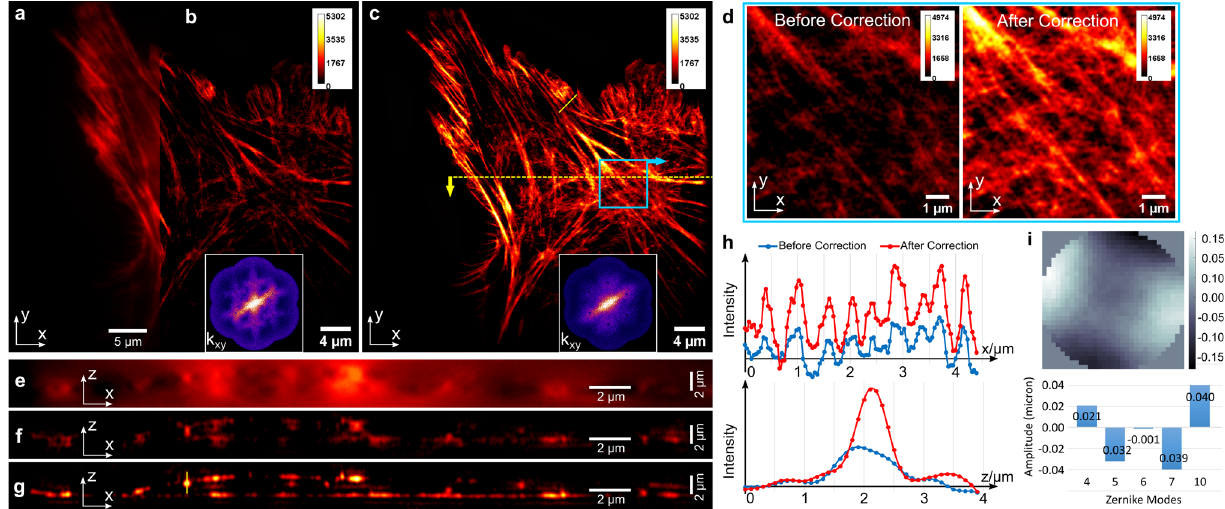
Fig. 3 The actin of α -TN4 lens epithelial cell, labeled with Phalloidin-iFluor 647. a Wide fi eld fl uorescence image with AO correction. b 3D-SIM image without AO correction and the OTF section at k z = 0 (inset). c 3D-SIM image with AO correction and the OTF section at k z = 0 (inset). All three images are x-y slice of the 3D images in the focal plane (z = 0). d Zoomed-in views of the actin structures before (left) and after (right) AO correction. The x-z slice cut through the dashed yellow line in c . e wide fi eld with AO; f 3D-SIM; g AO-3DSIM. h Intensity pro fi le along the solid yellow lines in x-y and x-z slice images, respectively. i The amplitudes of Zernike modes and the wavefront posted on the DM, units in